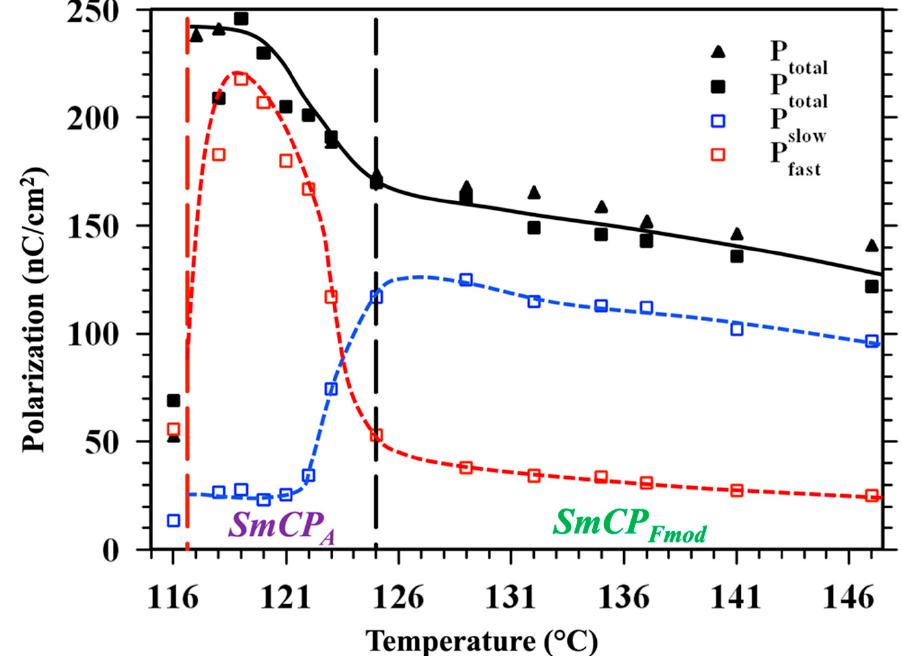
Figure 5. Temperature dependence of the ferroelectric polarization, as calculated from the areas below the current peaks. Triangular symbols indicate the values measured under triangular wave voltages, and rectangular symbols correspond to data extracted from the measurements under rectangular voltage waveform. Open rectangles correspond to the areas of the slow (blue) and fast (red) peaks, while solid black rectangles are the sums of these two areas. The polarization values were determined with better than 10% precision.